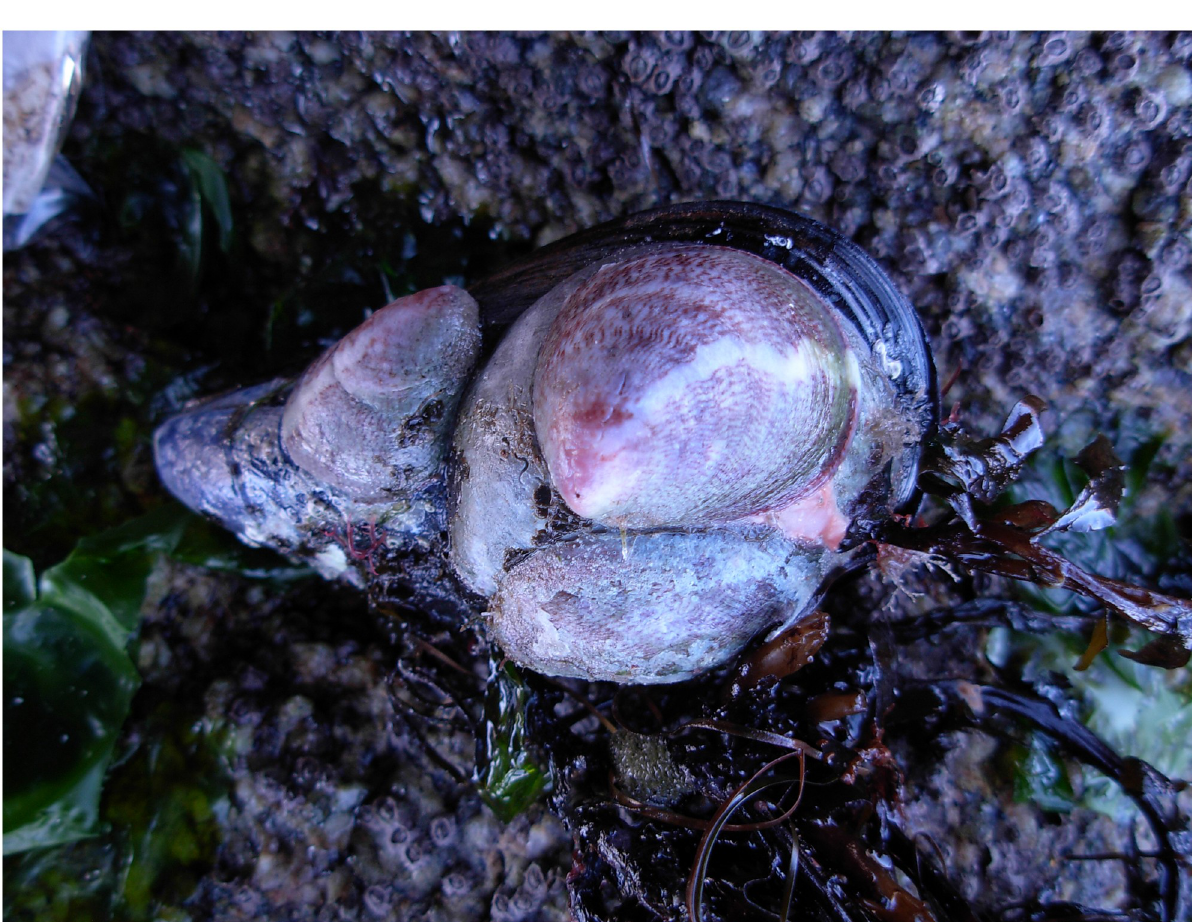
Fig 9. A living native mussel from O Grove with a Crepipatella dilatata aggregation.